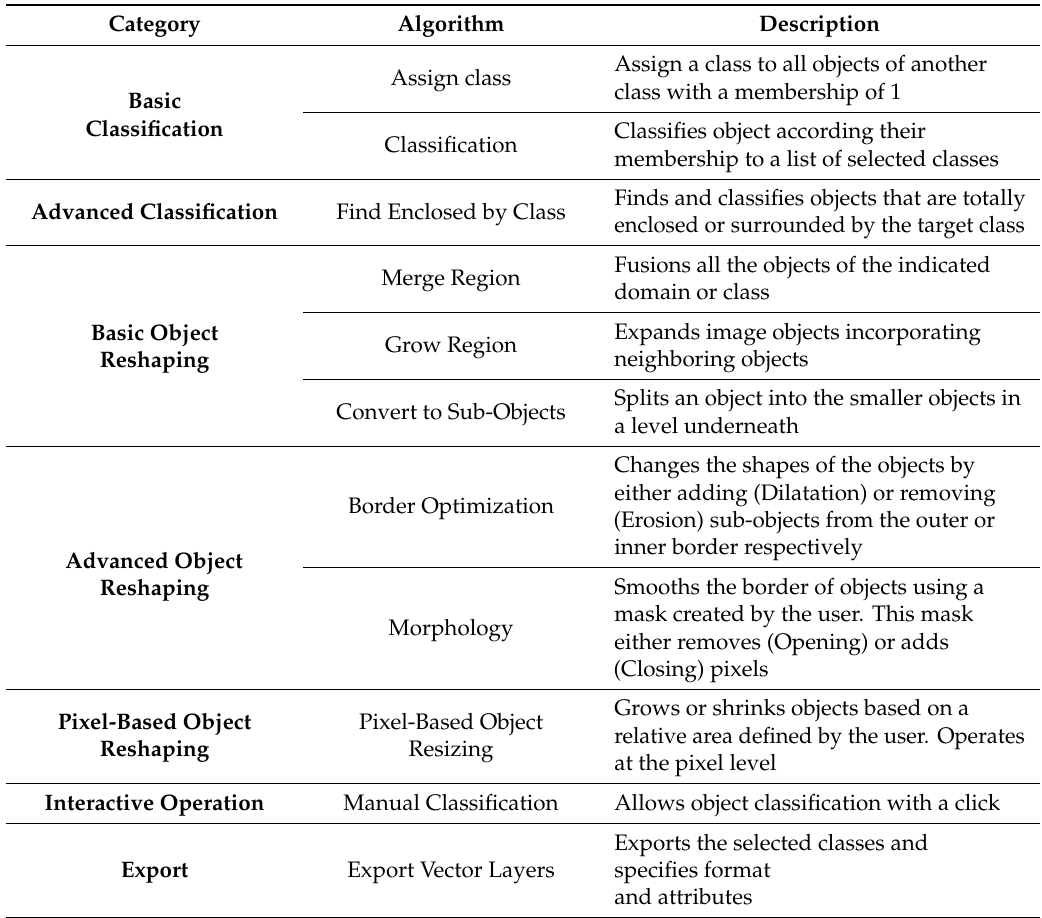
Table 2. List of algorithms used in eCognition during raster classification